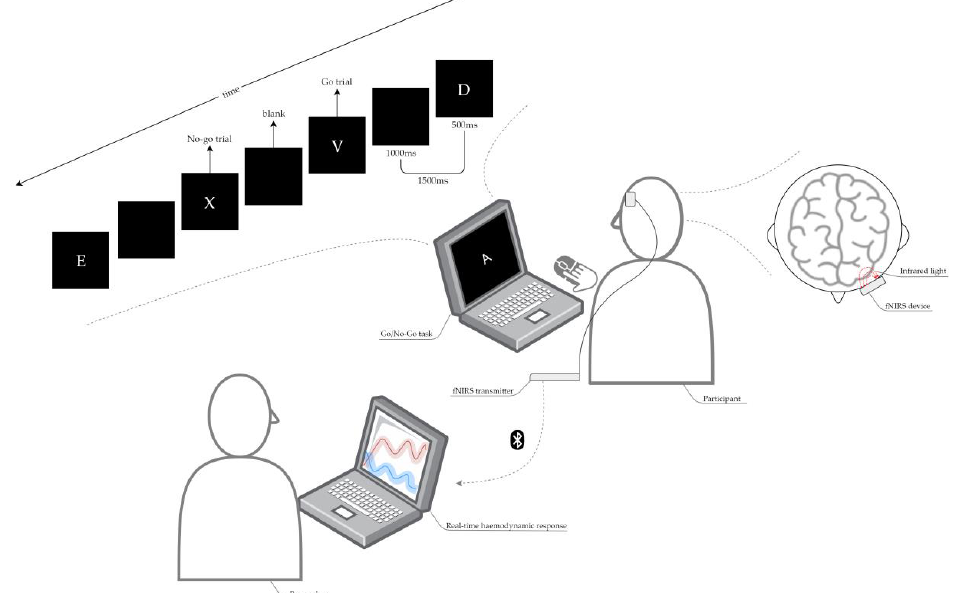
Figure 3 . A graphical representation of the fNIRS setup. Each participant involved in the brain activity assessment completed the following protocol: (A) it was explained to the participant how to perform the cognitive task (i.e., Go/No-Go task) and completed a the cognitive task (i.e., Go / No-Go task) and completed a practice session; (B) the participant was fitted practice session; (B) the participant was fitted with the fNIRS device probe on the forehead with the fNIRS device probe on the forehead in the area corresponding to their dorsolateral prefrontal in the area corresponding to their dorsolateral prefrontal cortex; (C) the participant cortex; (C) the participant completed the Go / No-Go task while the researcher concurrently recorded the completed the Go/No-Go task while the researcher concurrently recorded the task-related task-related haemodynamic haemodynamic response.